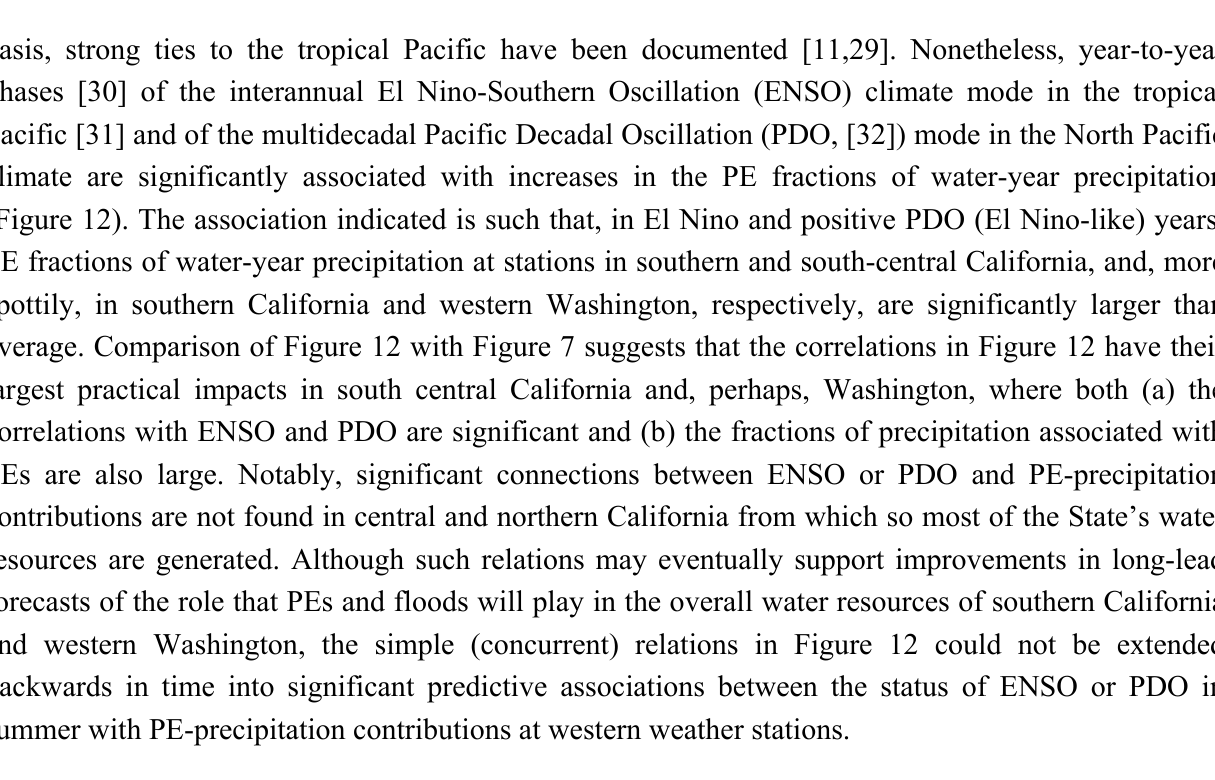
Figure 11. Averages of contributions to water-year total precipitation on PE days (plus day +1) at 202 cooperative weather stations in central and northern California (same area as defined in caption of Table 3),